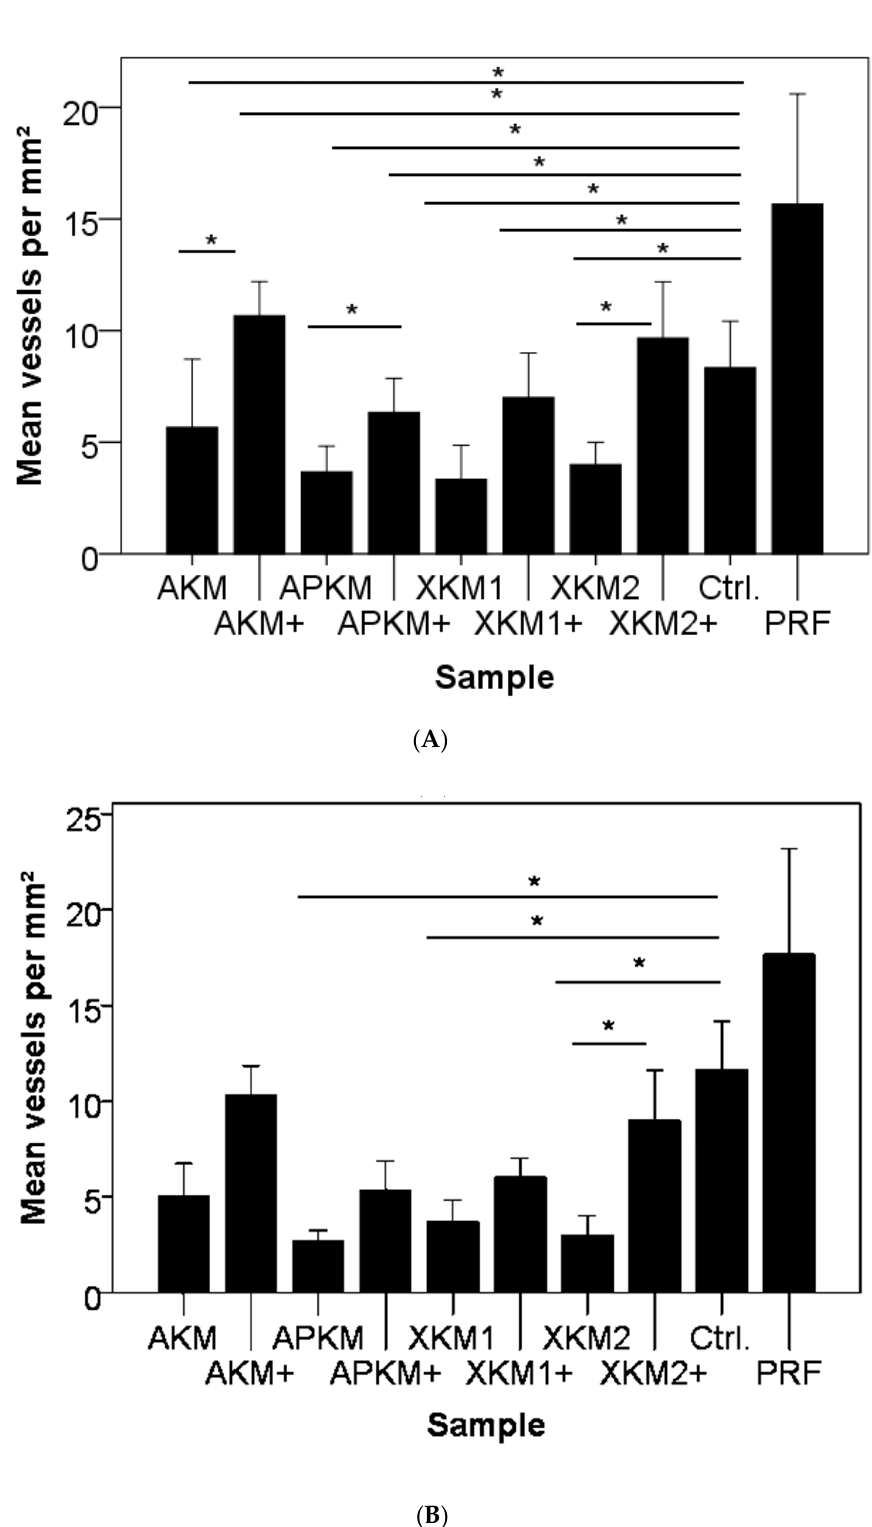
Figure 7. Newly formed vessels per mm 2 after HE ( A ) and after α SMA staining ( B ) after the removal of each BSM with (+)/without PRF in comparison to the negative control and PRF alone (* p < 0.05) .